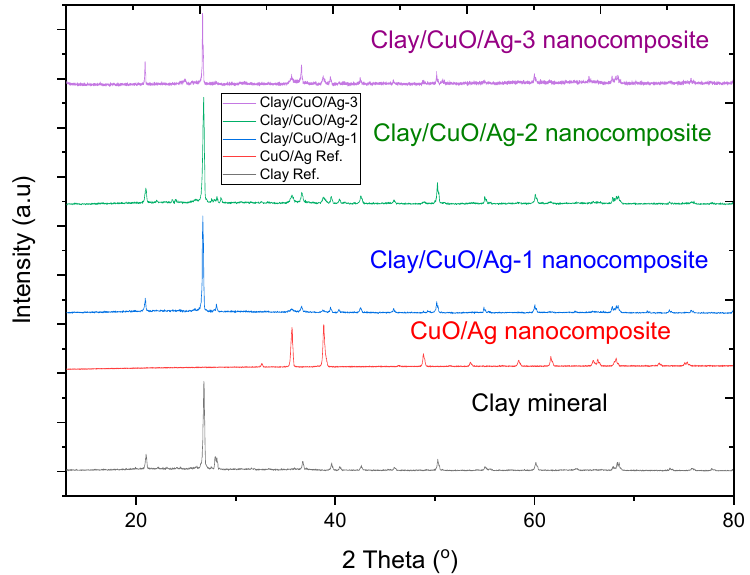
Figure 9. XRD spectra pattern of clay mineral, CuO / Ag, clay / CuO / Ag. Clay / CuO / Ag-1, clay / CuO / Ag-2, clay / CuO / Ag-3 contain 2.5%, 5% and 10% of CuO / Ag, respectively.